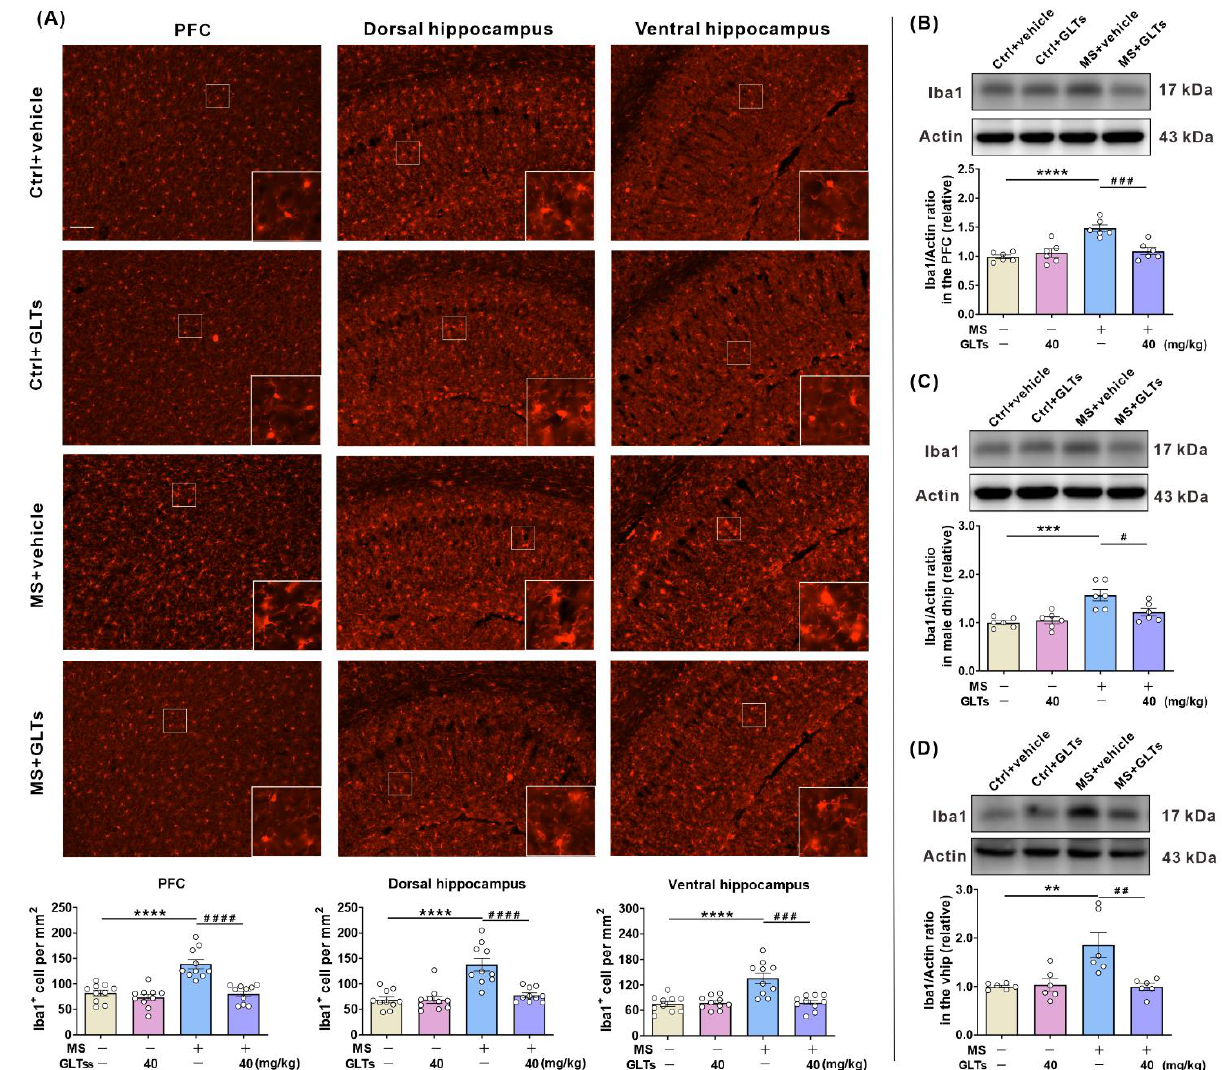
Figure 5. The inhibited maternal separation-induced microglial activation in the PFC and hippocampus by GLTs treatment. ( A ) Representative images of microglia and quantification analysis of microglia number in the PFC, dorsal, and ventral hippocampus of MS and control mice. Scale bar, 100 μm. ( B – D ) Representative western-blot and quantification of Iba1 in the PFC ( B ), dorsal hippocampus ( C ), and ventral hippocampus ( D ). Data are expressed as mean ± SEM, n = 10/group. ** p < 0.01, *** p < 0.001, **** p < 0.0001, as compared with Control + vehicle group; # p < 0.05, ## p < 0.01, ### p < 0.001, #### p < 0.0001, as compared with MS + vehicle group.